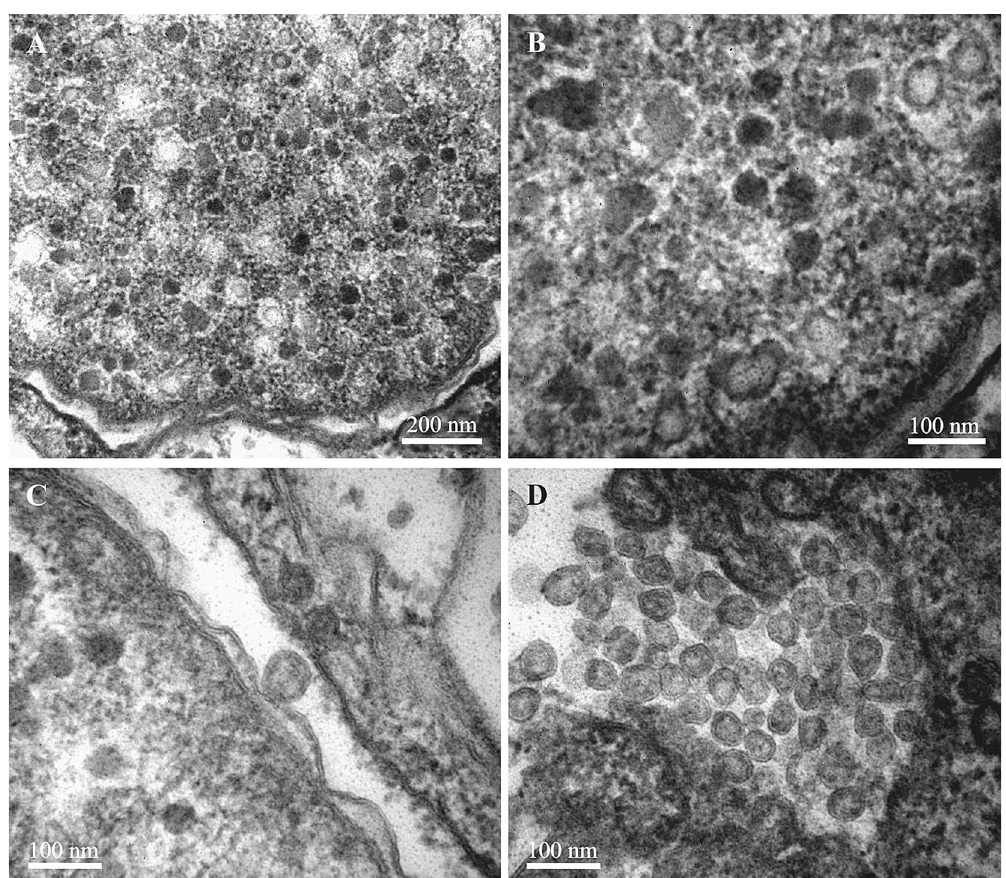
Figure 4. Virus-like particles associated with symbiotic bacteria in the tentacles of Bugula neritina . ( A , B ) Electron-dense and electron-translucent VLPs inside the cytoplasm of the bacterial cell of ‘type III’. ( C ) VLP inside (left) and on the surface of the bacterial host. ( D ) virions outside bacteria between epithelial cells of a bryozoan.